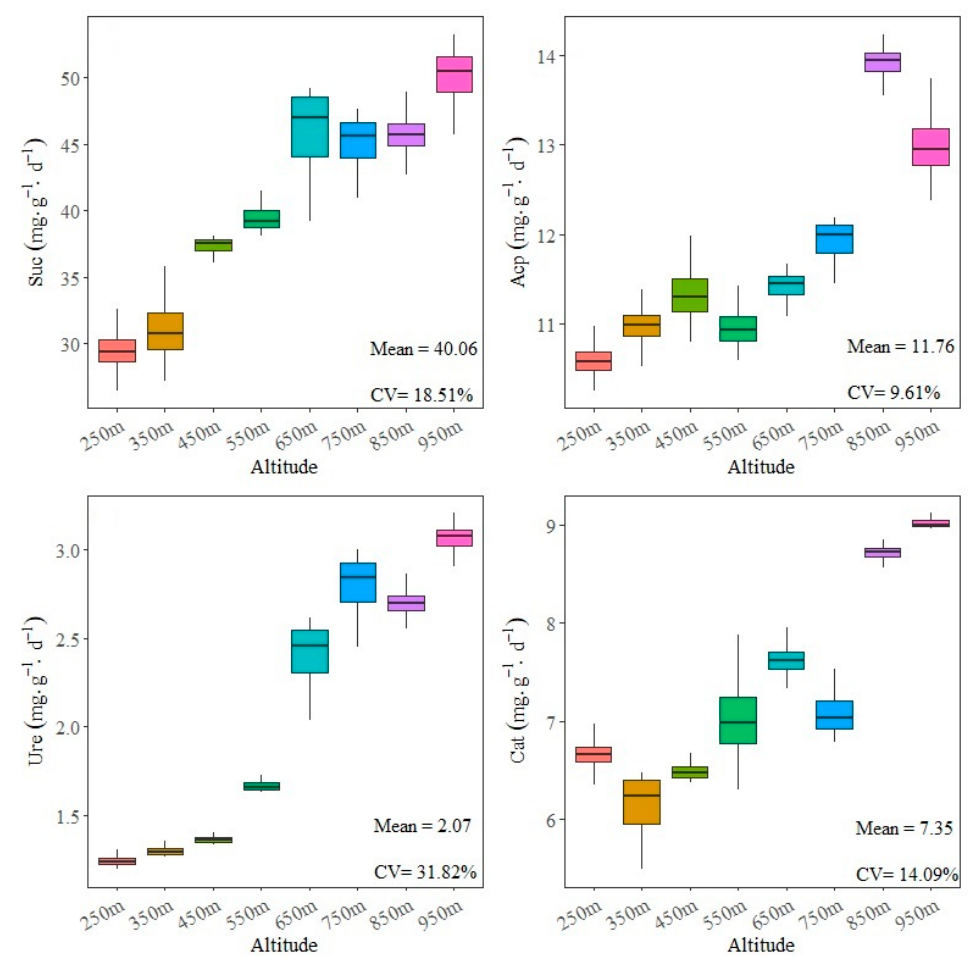
Figure 4. Soil enzyme activities at di ff erent altitudes.